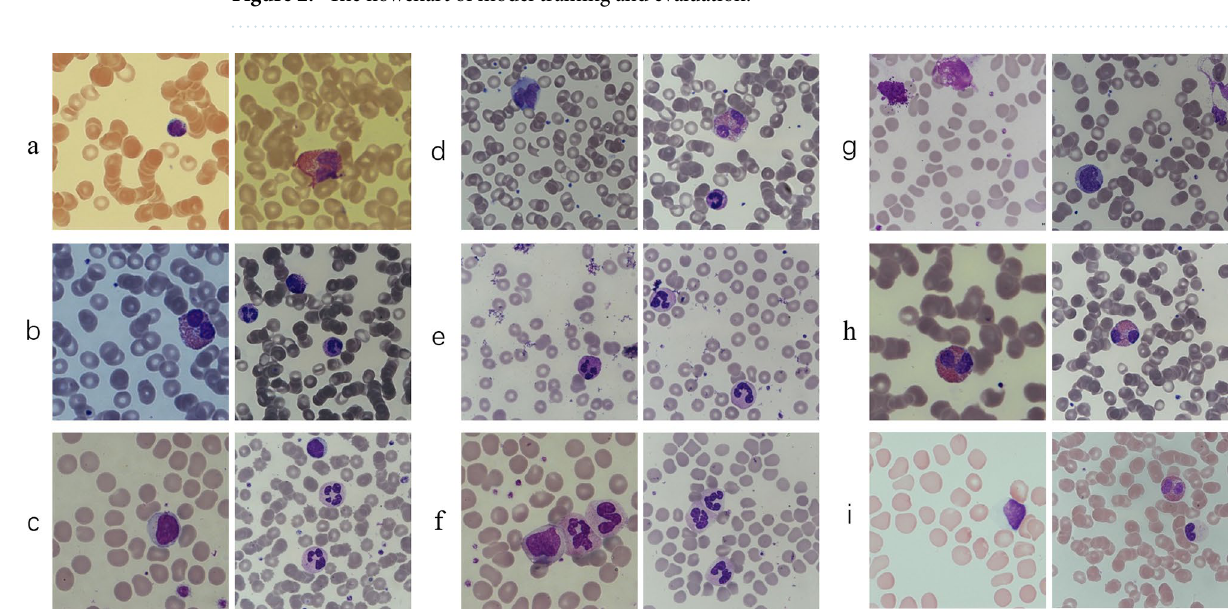
Figure 2. The flowchart of model training and evaluation.